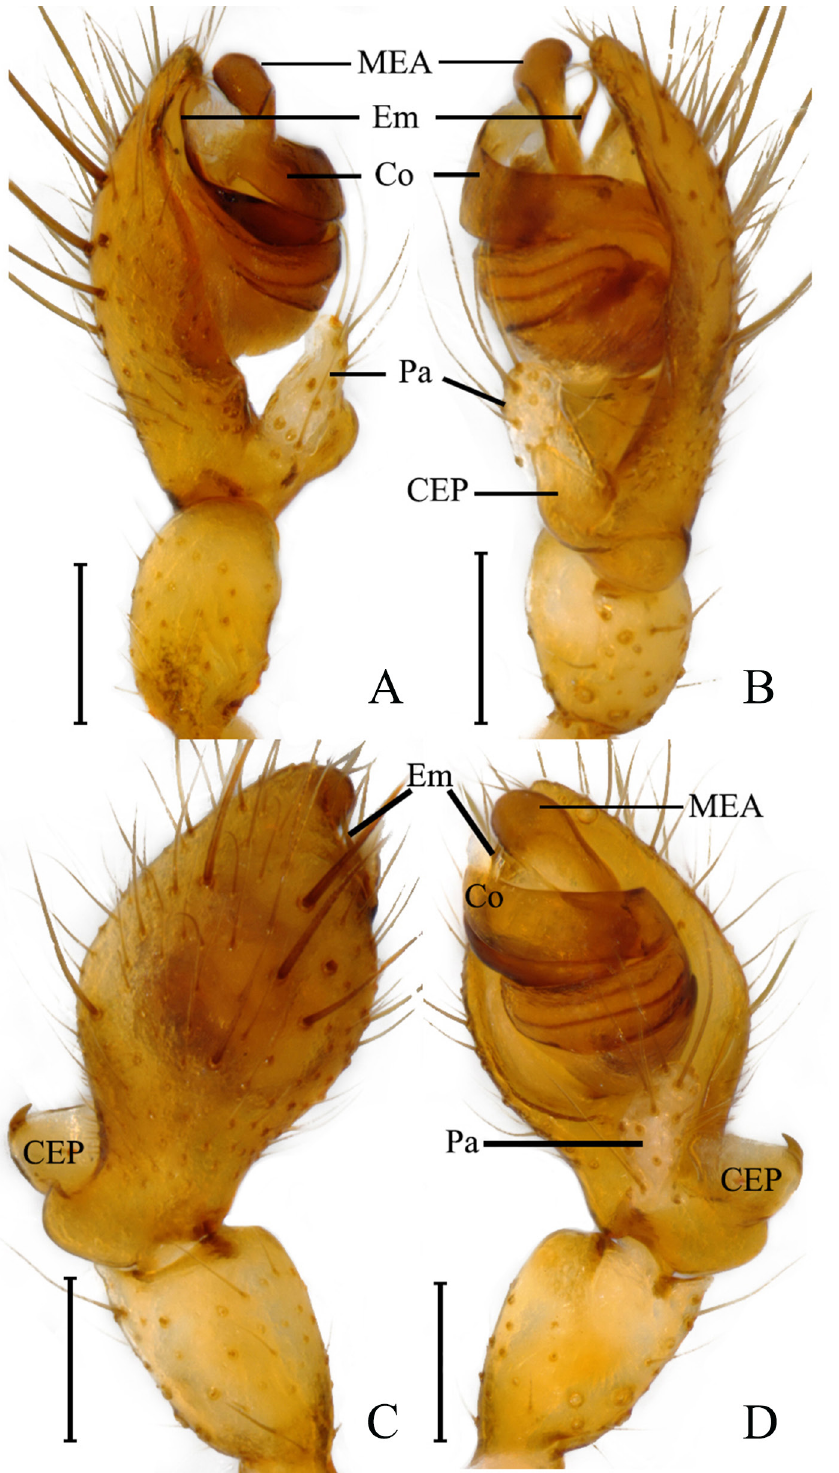
Fig. 5. Meta longlingensis sp. nov. Left palp of holotype ♂ (HNU-Tang031029). A . Prolateral view. B . Retrolateral view. C . Dorsal view. D . Ventral view. Scale bars: 0.2